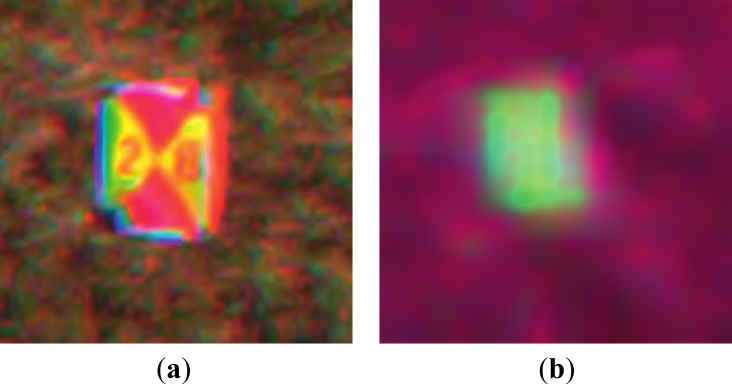
Figure 5. An image of the used targets acquired during a normal photogrammetric flight with a RGB camera ( a ), and the same target in the ADC Micro image ( b ). For all datasets we ensured a re-projection error at the end of the bundle adjustment solution smaller than 1 pixel.